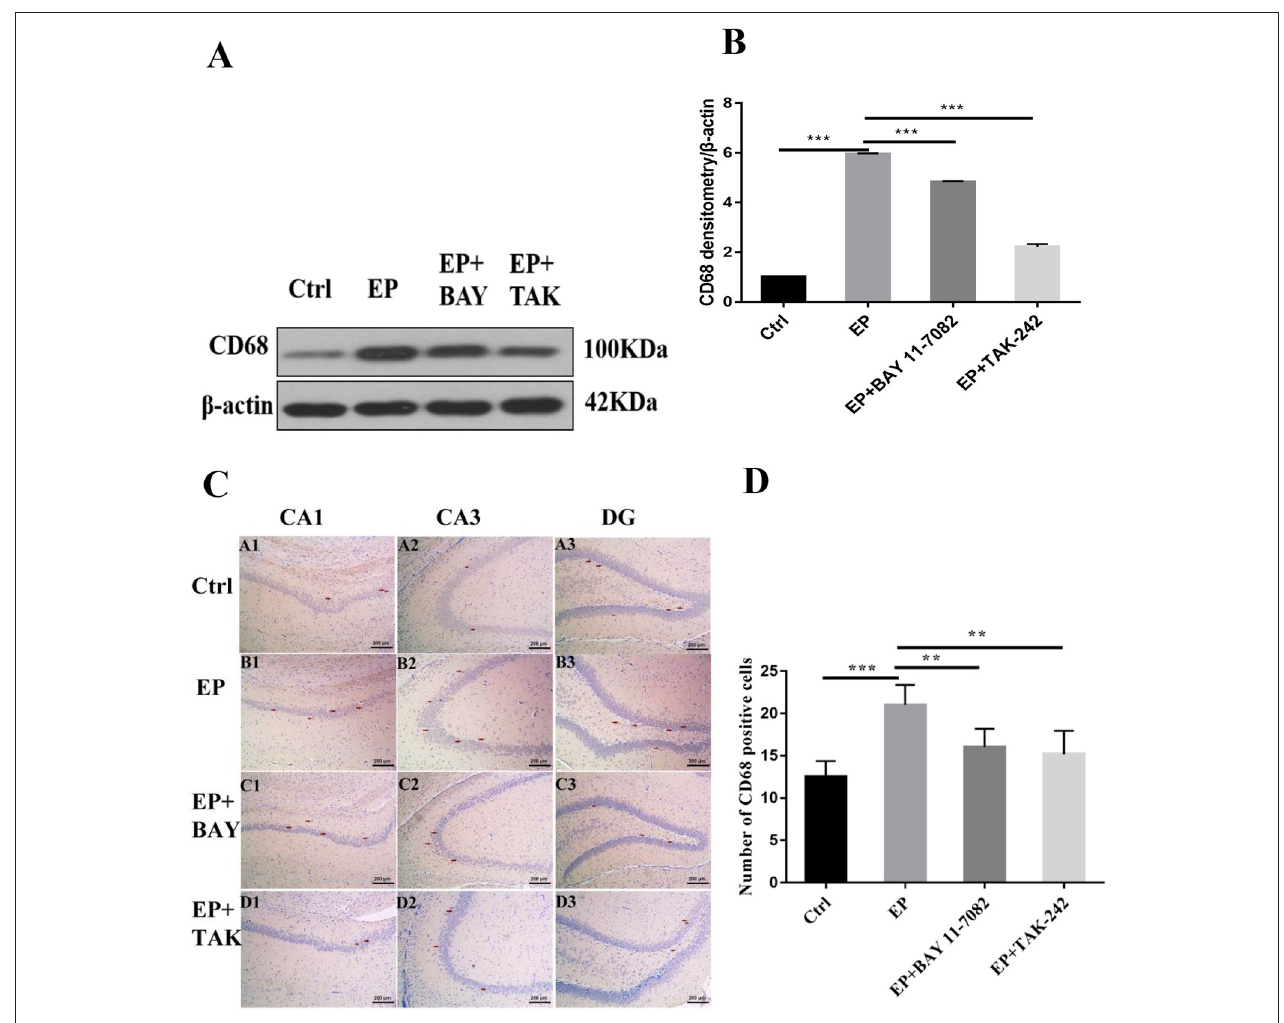
FIGURE 5 | (A–D) Changes in CD68 protein expression in the hippocampus of rats in each group after SE seizures. * P < 0.05; ** P < 0.01; *** P <